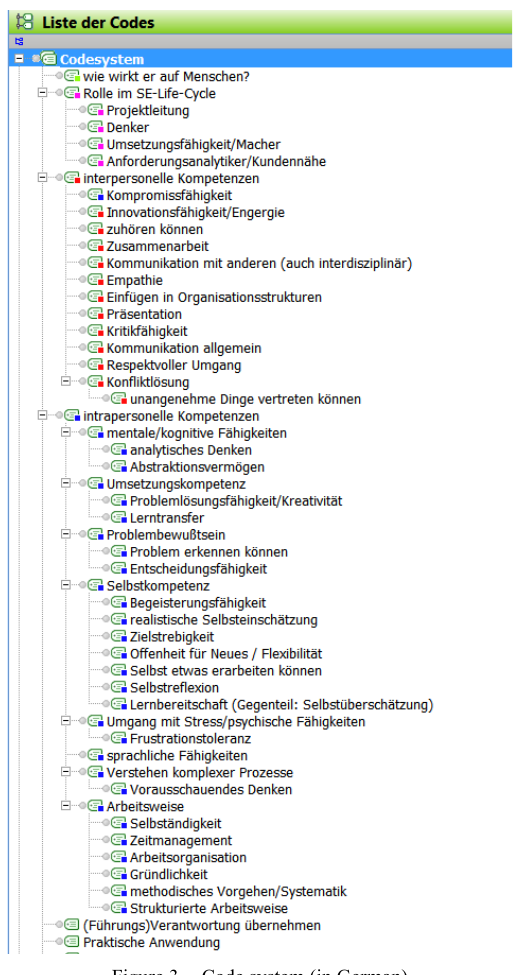
Figure 3. Code system (in